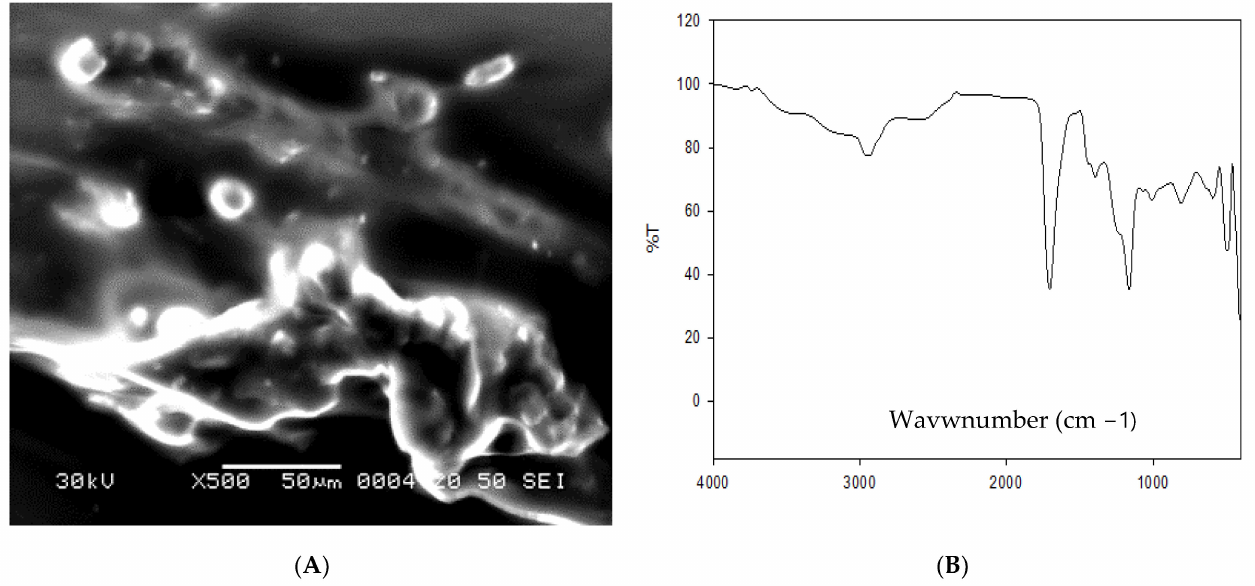
Figure 1. Scanning electron microscopy ( A ) and Fourier-transform infrared spectroscopy (FTIR, ( B )) of omega-3